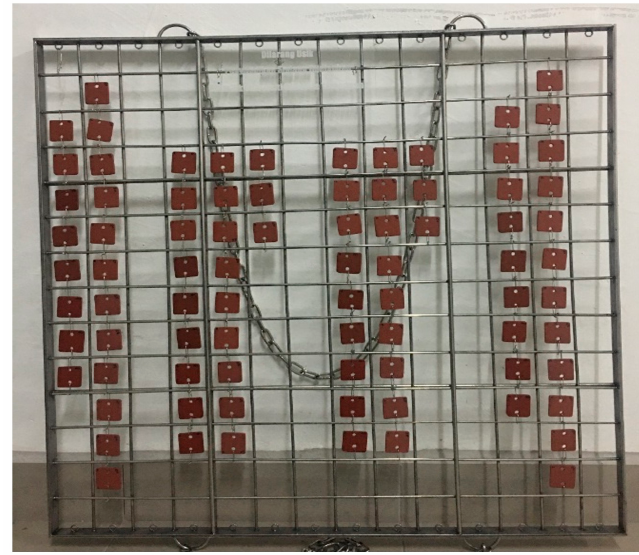
Figure 4. Stainless steel frame with coated steel panels for testing.